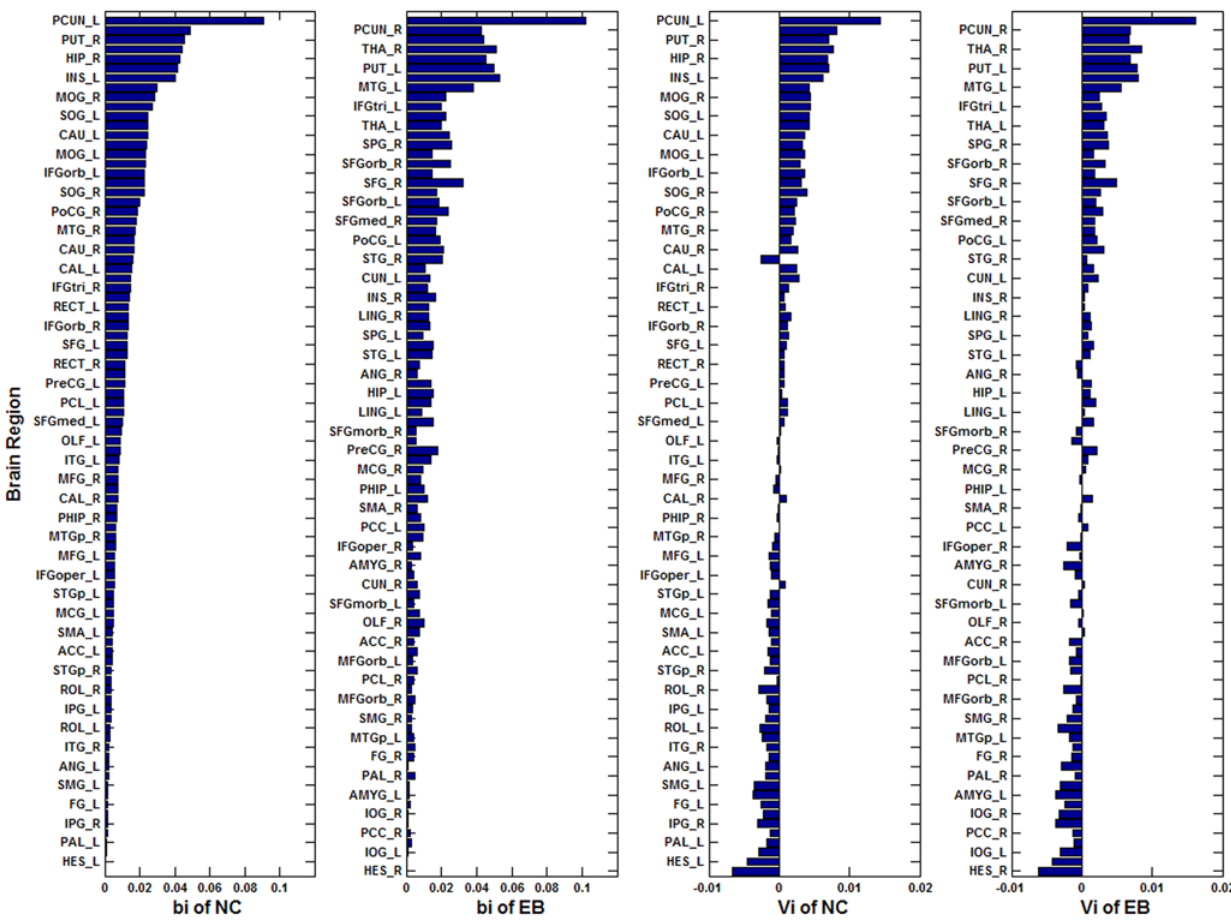
Figure 1. Comparison between two groups with respect to the b i and V i for each brain region. The length of the bar indicates the mean values sorted by the mean b i of the NC group in descending order. Left two columns compare the b i values of the control with those of the early blind. Right two columns make the same comparison for the V i values.